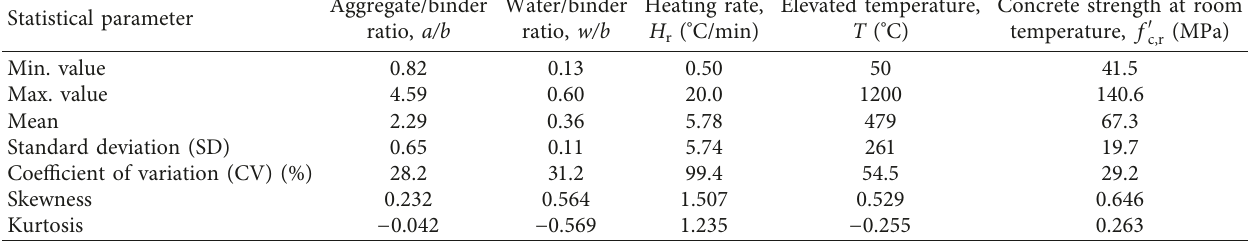
Table 3: Statistics of input parameters (485 data points).